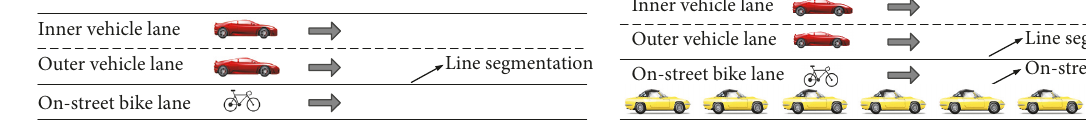
Figure 1: Illustration of a typical street